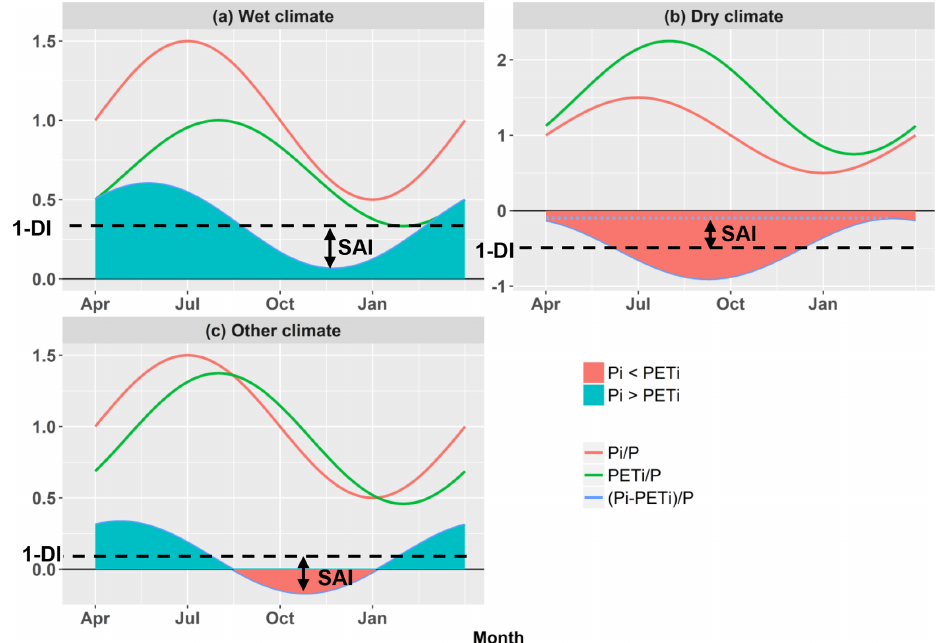
Figure 3. Examples of three scenarios for the mismatch between water and energy in terms of the relationship of SAI to 1-DI. (a) SAI smaller than 1-DI, implying P larger than PET for the whole year. (b) SAI smaller than DI-1, implying P smaller than PET for the whole year. (c) SAI smaller than 1-DI, implying a larger SAI means more surplus of P . The shaded areas represent the difference between precipitation and potential evapotranspiration, which is equal to ( 1 − DI ) + SAI sin